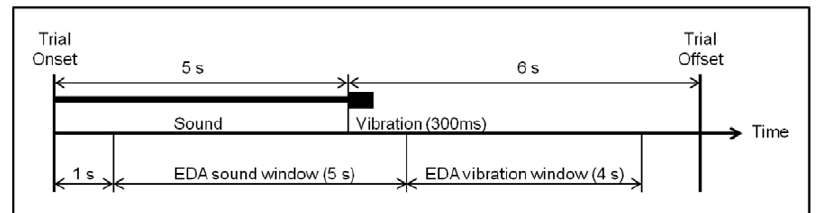
Figure 1. Timeline of a single conditioning trial. After the presentation of an auditory stimulus that was 5 seconds long tactile stimulus was presented. Between the onsets of two consecutive trials there were 11 seconds. Figure also shows the time windows in which EDA was scored.